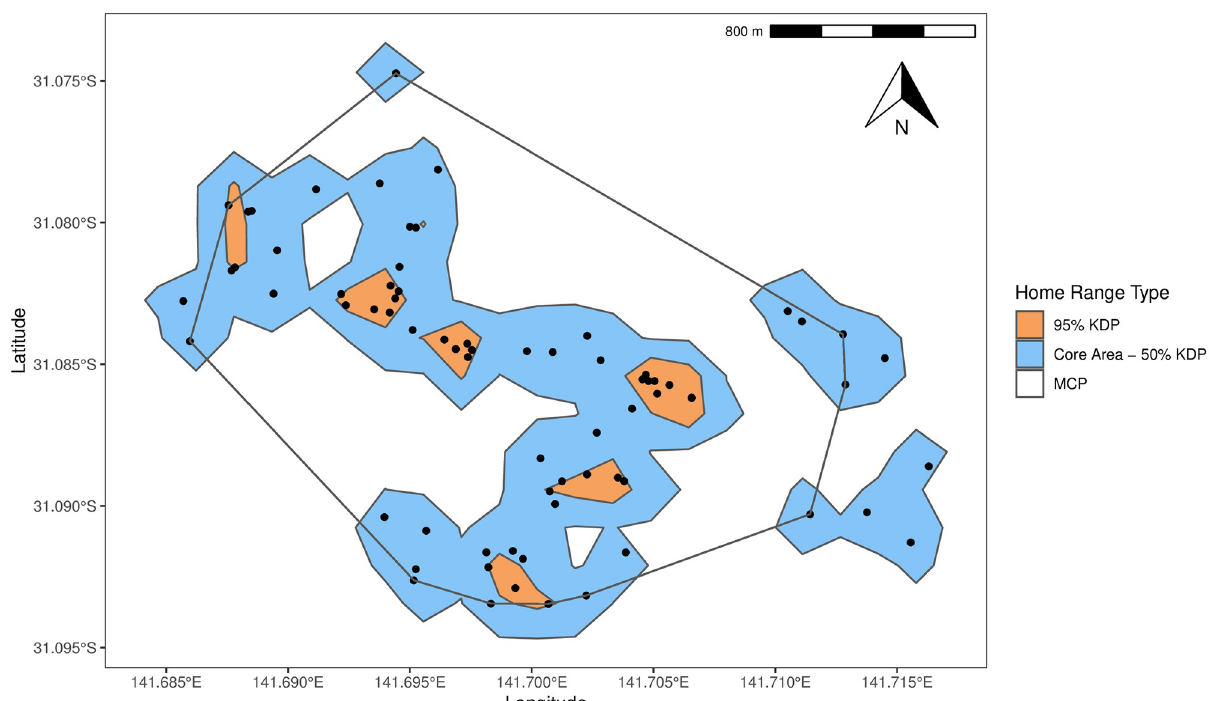
Fig 1. Minimum convex polygon, 95% kernel and core area of E6 including individual data points.